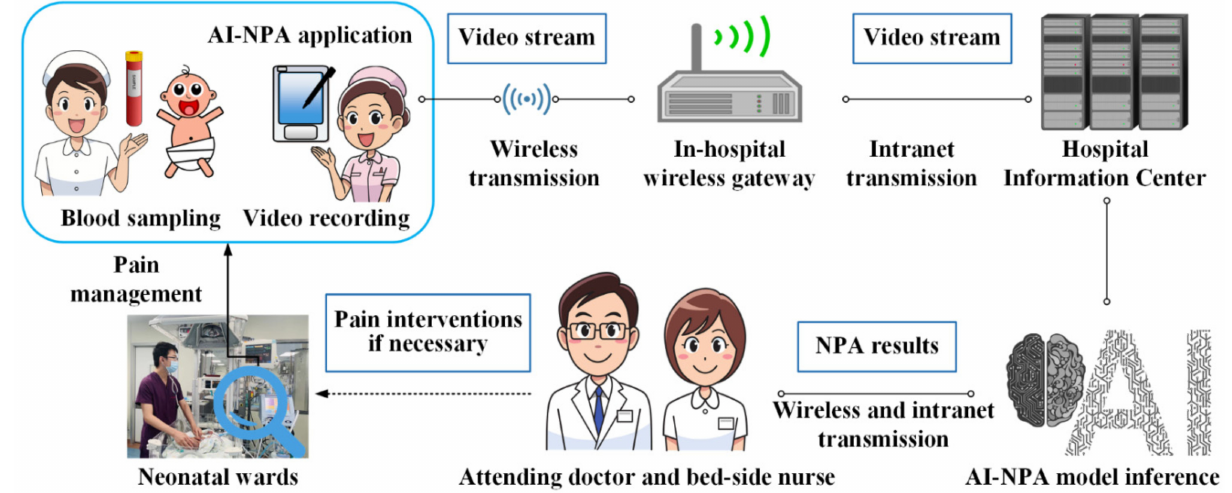
Figure 5. The framework of the automated NPA system and its